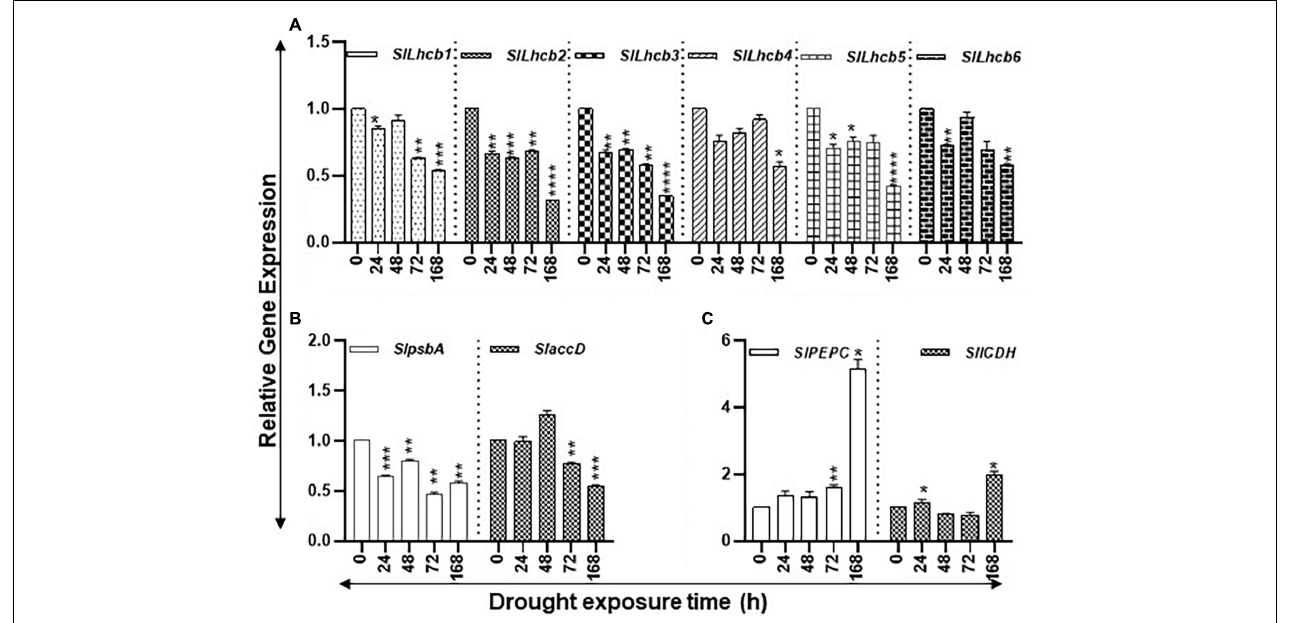
FIGURE 3 | Effect of drought on the steady state abundance of chlorophyll a/b-binding, plastid-encoded photosystem II (PSII), and carbon flow gene transcripts in tomato leaf tissue. Quantitative PCR was used to determine the steady state levels of transcripts of (A) nuclear-encoded light-harvesting chlorophyll a/b-binding protein genes ( Lhcb1-6); (B) Plastid-encoded photosystem II (PSII) genes ( psbA and accD) ; and (C) phosphoenolpyruvate carboxylase ( PEPC ) and isocitrate dehydrogenase ( ICDH ) genes. Other details are the same as in Figure 1 . **** indicates significance at p -value of <